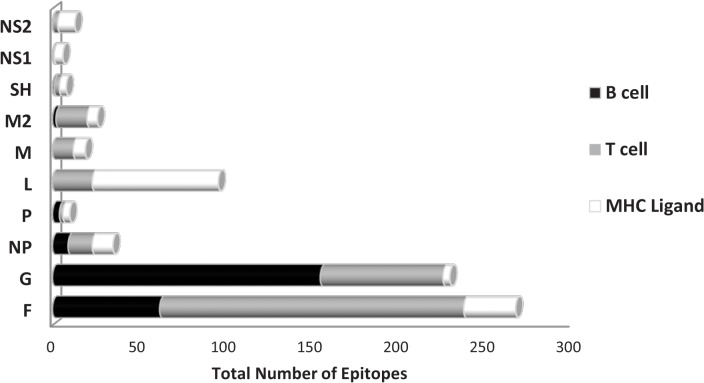
Response by RSV protein.The total number of unique epitopes reported to date for each RSV protein are shown. Data are then further broken down into response type, antibody/B cell (black), T cell (grey) and MHC ligand (elution and binding combined; white). The percentages provided represent the portion of the total RSV-specific data.